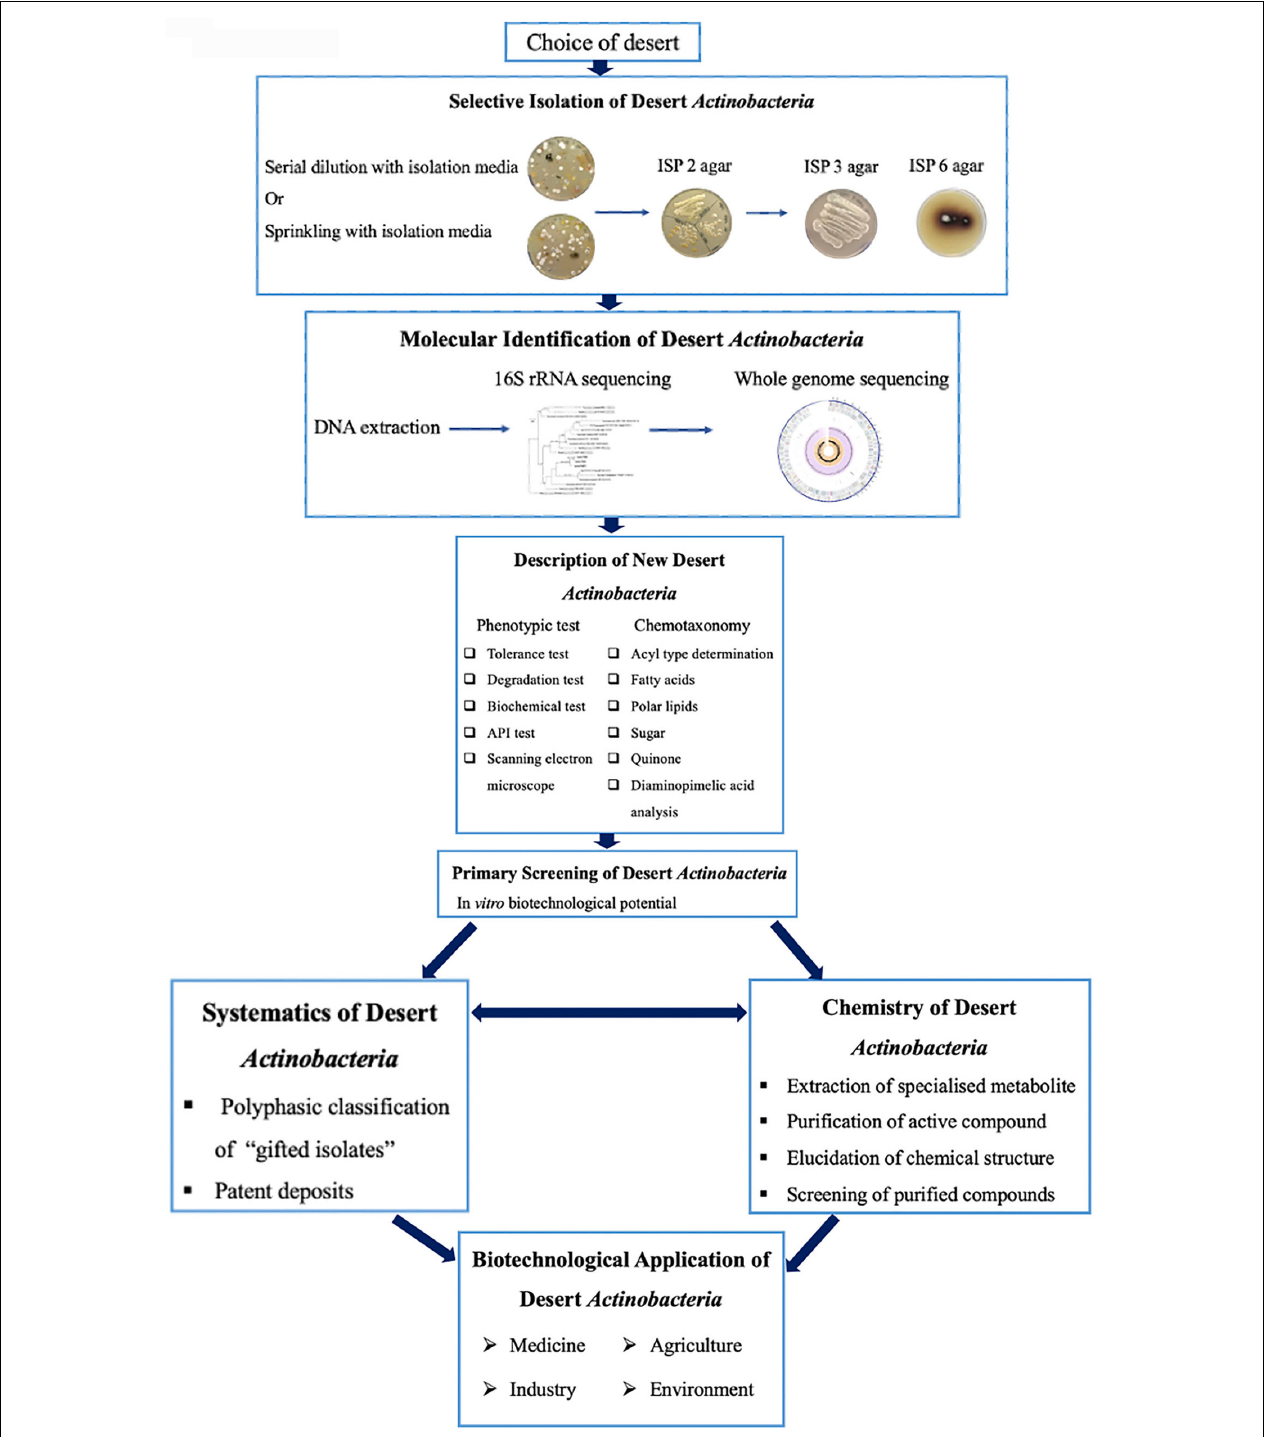
FIGURE 4 | Bioprospecting strategy for desert actinobacteria (modified from Goodfellow and Fiedler, 2010).